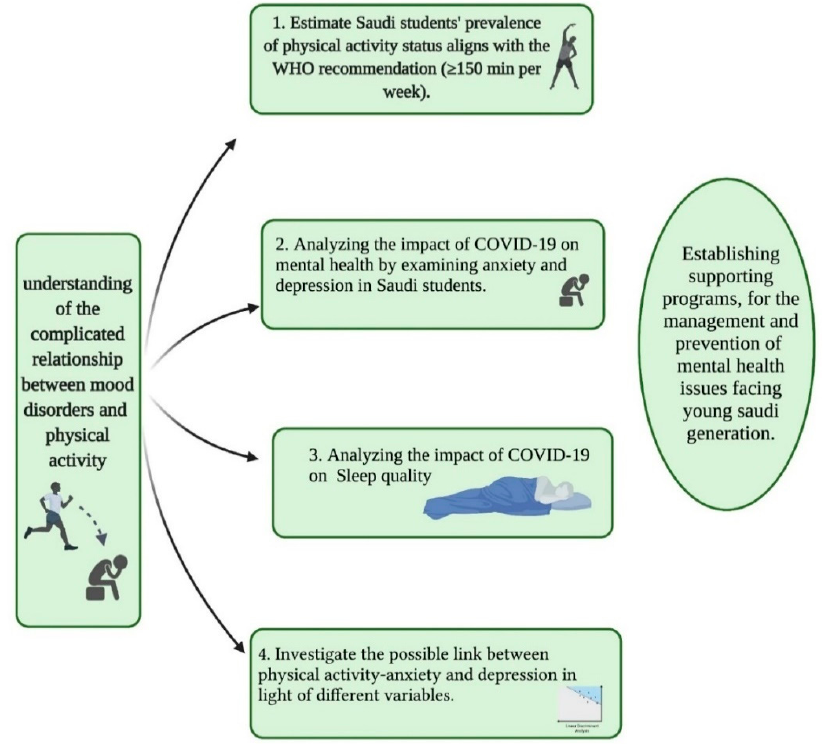
Figure 1. The specific aims of the study.